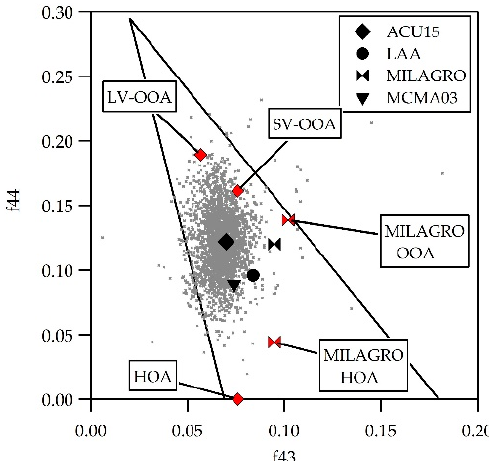
Figure 11. f44 vs. f43 of the Organics mass spectra. Grey points correspond to all data points during ACU15. Black symbols correspond to average f44 vs. f43 during the AMS campaigns [13,18,19]. Red symbols correspond to the PMF OOA factors during ACU15 and MILAGRO [13].